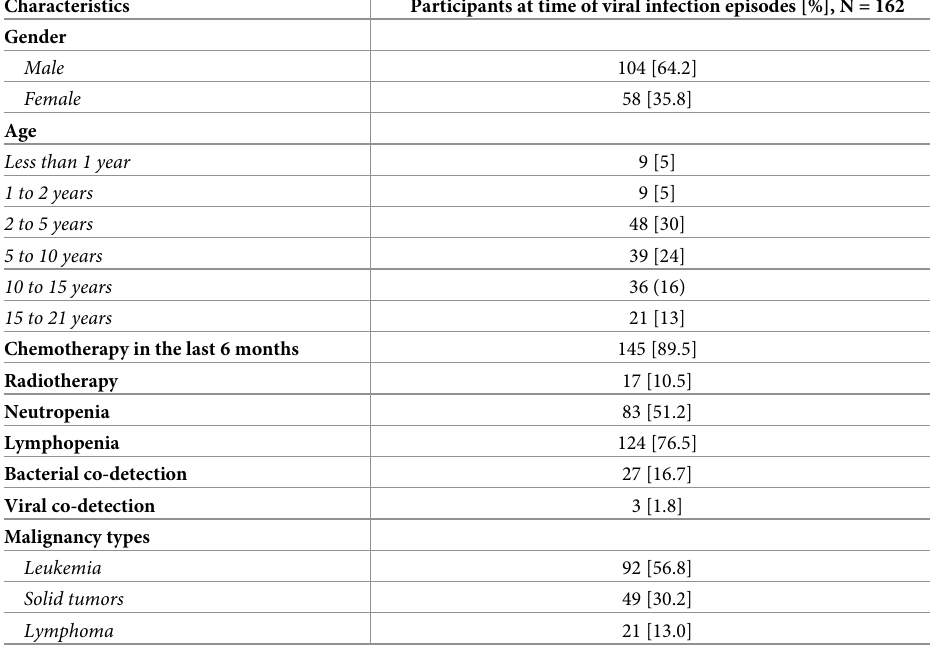
Table 2. Socio-demographic characteristics, laboratory findings, and malignancy types of participants at times of viral infection episodes.